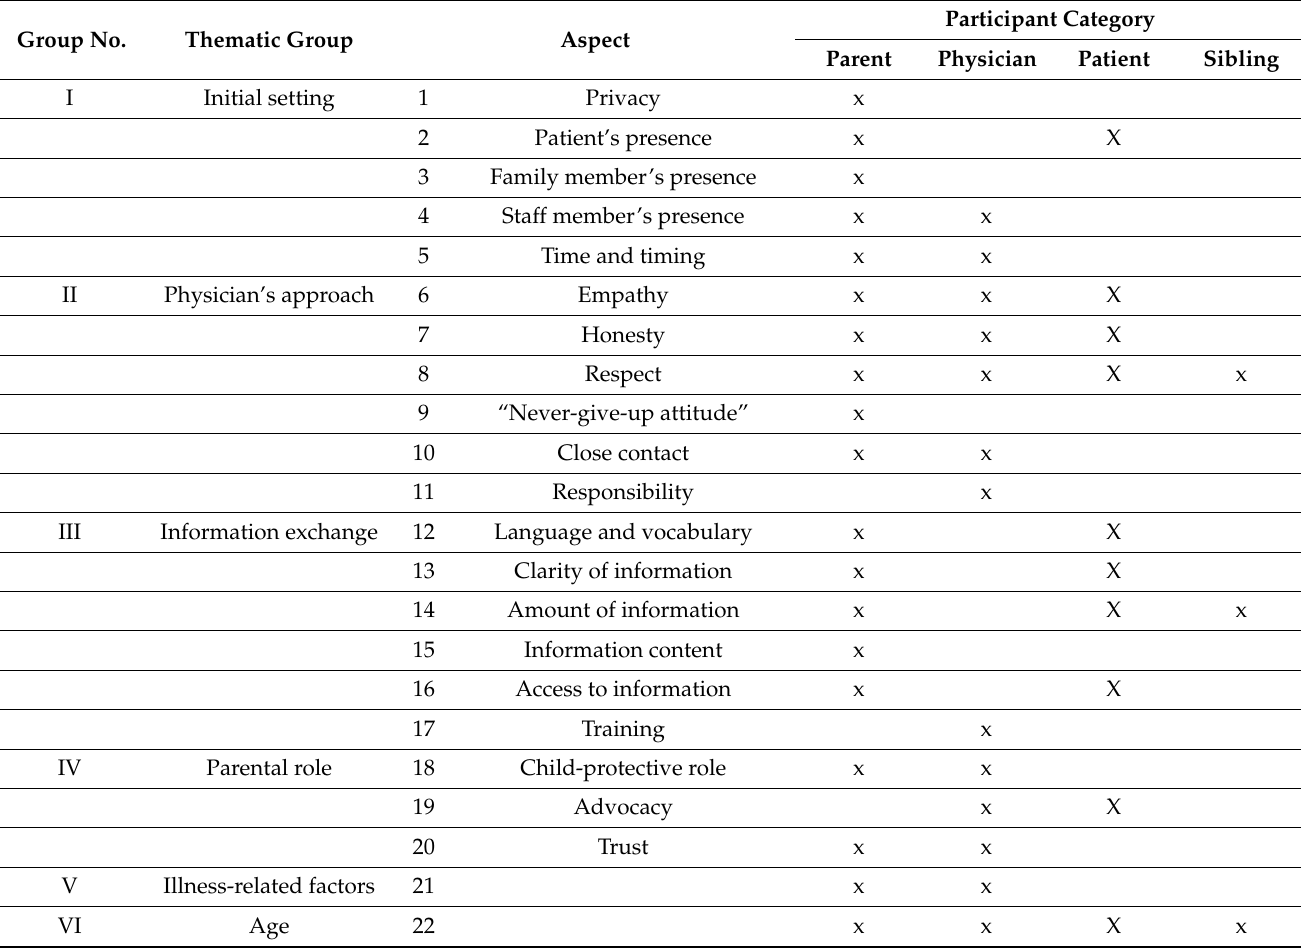
Table 1. Aspects of the communication process in delivering serious news. Group